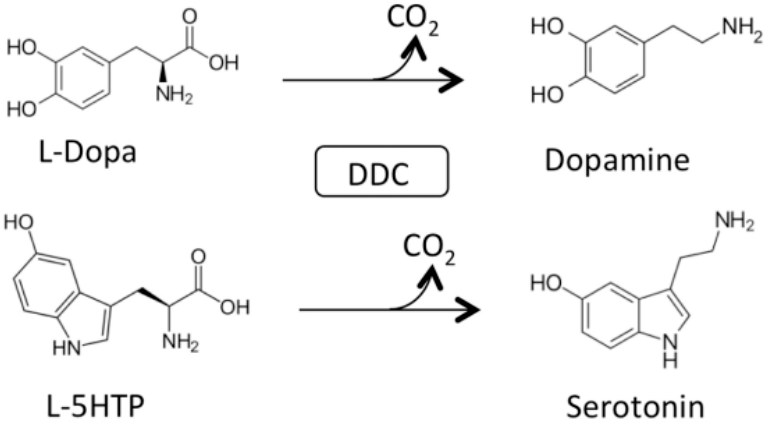
Figure 1. Main physiological reactions of Dopa decarboxylase (DDC). Decarboxylation of L-Dopa and L-5-HTP catalyzed by DDC.